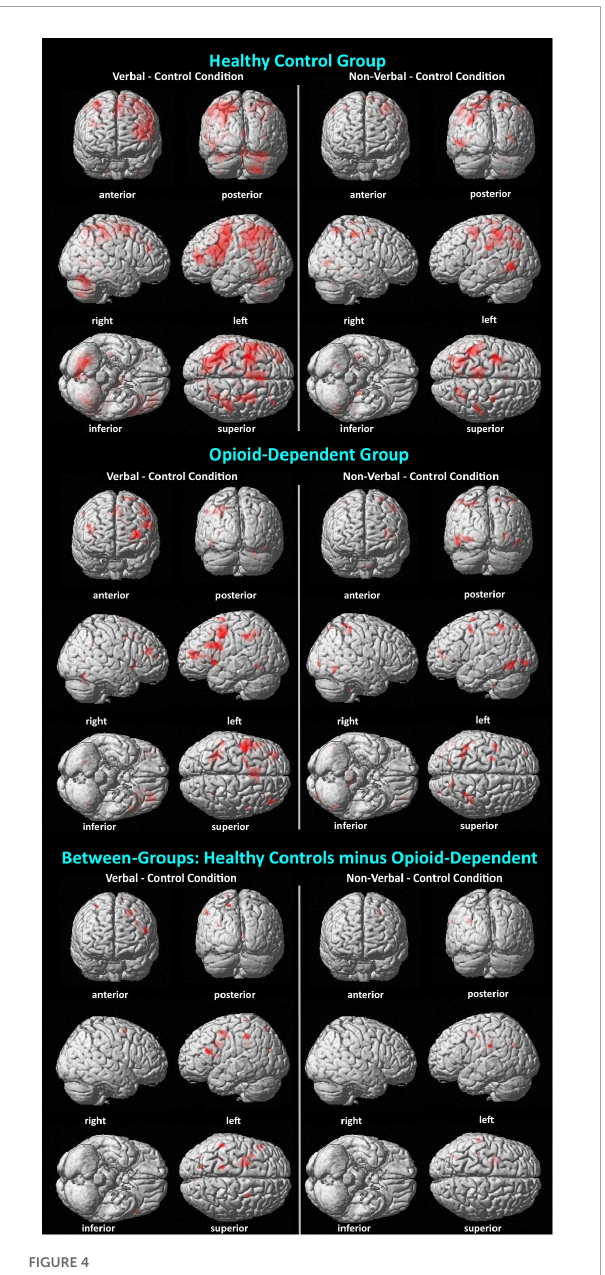
FIGURE4 Visualization of BOLD activation associated with verbal and non-verbal WM. Surface renderings of BOLD activations display activations listed in Table 4 , as well as activations that did not pass a cluster size threshold of p < 0.05. Thus, there are more activations shown here than in Table 4 . Minimum cluster size = 10 voxels; all activations p < 0.001. In all comparisons, the activations are shown for the WM condition (verbal or non-verbal) minus the control condition. In the between-groups comparison, activations reflect a double subtraction [HC (WM – control conditions) – OP (WM – control